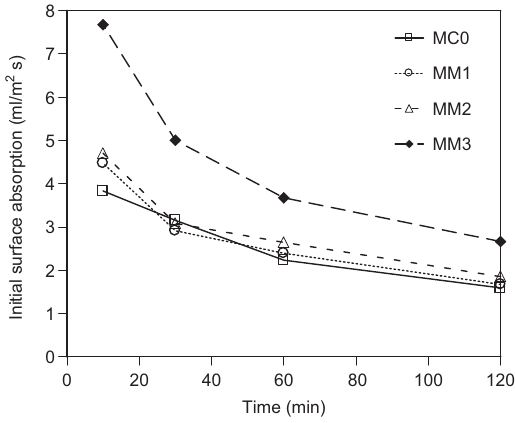
Figure 5 Initial surface absorption of cement mortars vs. the montmorillonite contents.